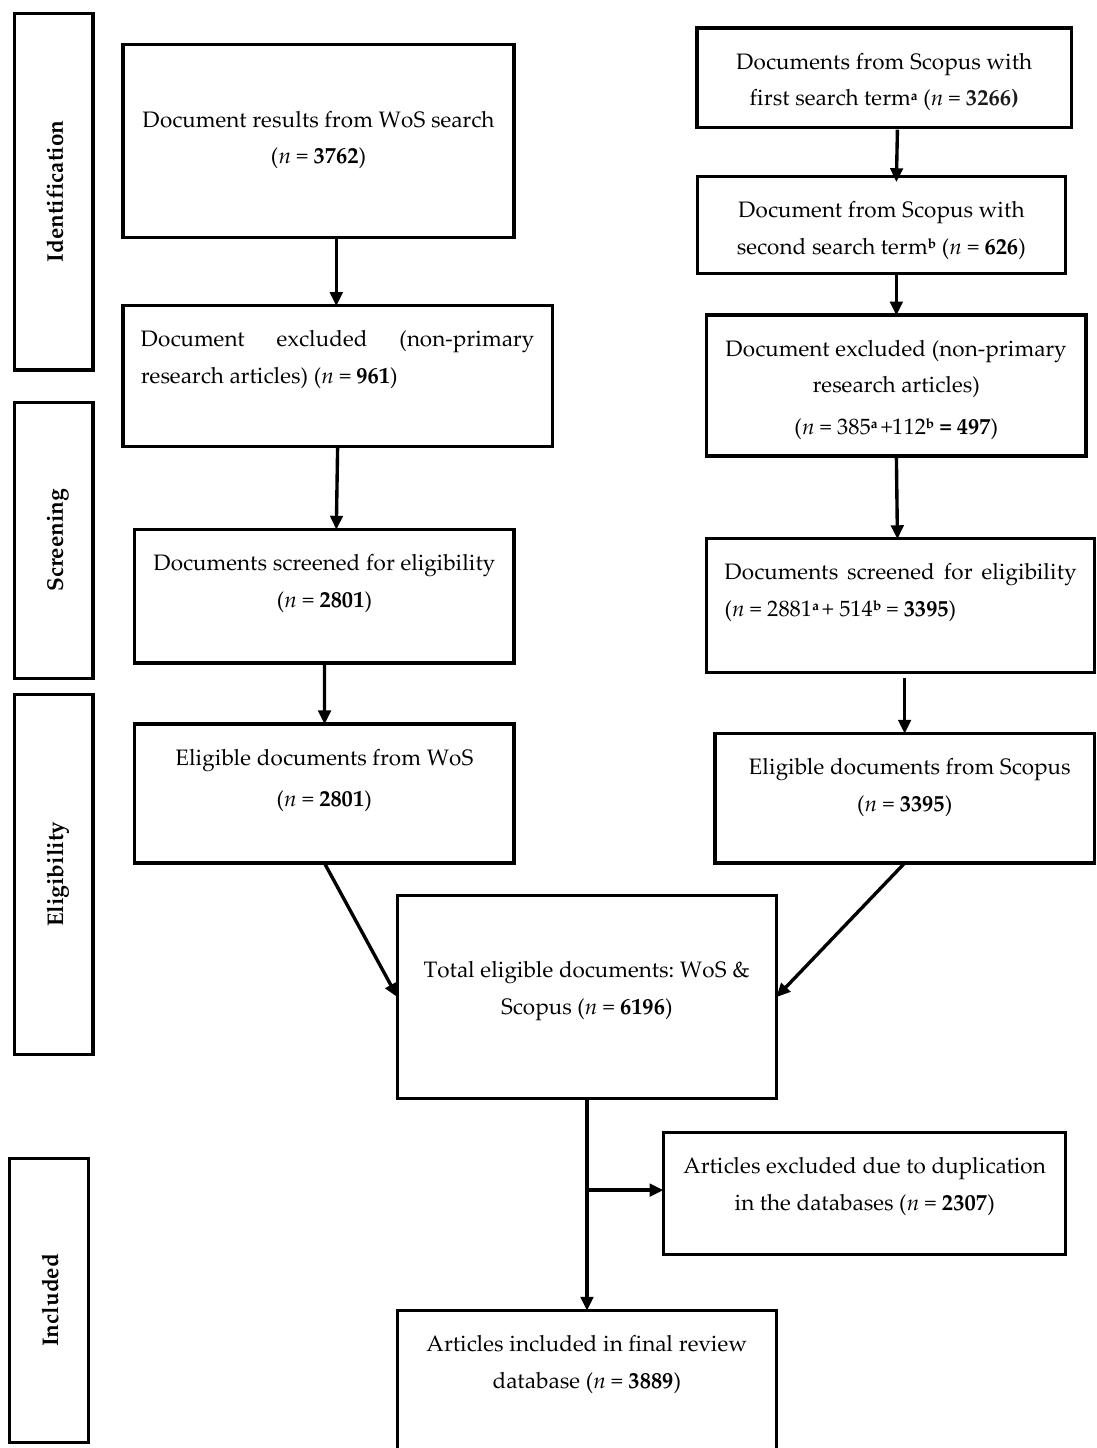
Figure 1. Preferred Reporting Items for Systematic Reviews and Meta-Analyses (PRISMA) flow chart for mining and screening Mycobacterium avium subsp. paratuberculosis (MAP) documents from 1911 to 2019 [22]. a = Scopus search with ‘paratuberculosis*’; b = Scopus search with ‘Johne’s disease’.